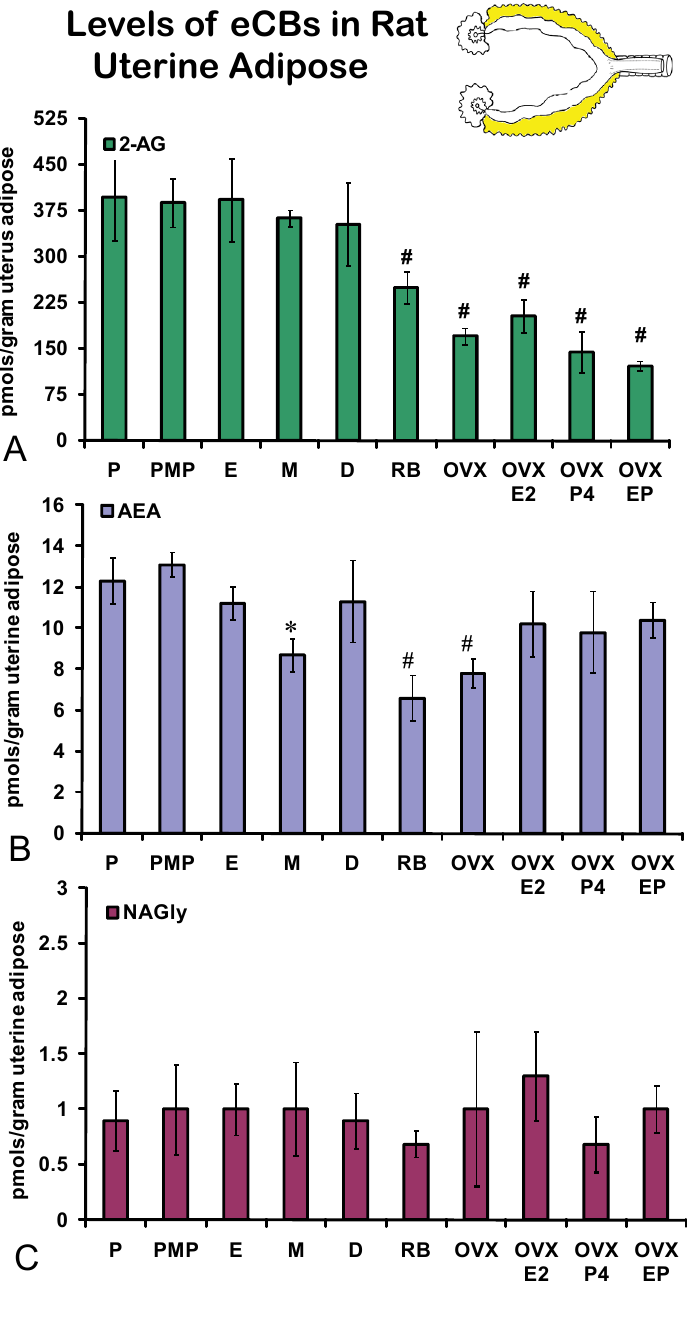
Figure 6. Levels of eCBs in rat uterine adipose tissue across the hormonal cycle, in anovulatory retired breeders (RB), after ovariectomy and hormone replacement. P = proestrus AM; PMP = proestrus PM; E = estrus; M = metestrus, D = diestrus; RB = anovulatory retired breeders; OVX = ovariectomy; E2 = 17 β estradiol; P4 = progesterone. * p ≤ 0.05 and represents comparisons across the hormonal cycle. # p ≤ 0.05 and represents comparisons of hormonal cycle groups with retired breeders and OVX treatment groups.